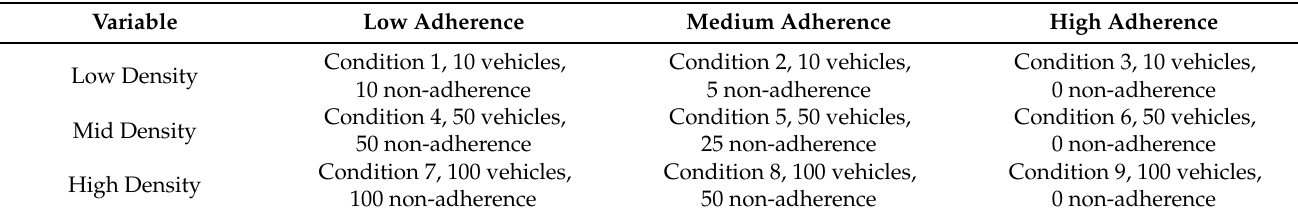
Table 4. Experiment